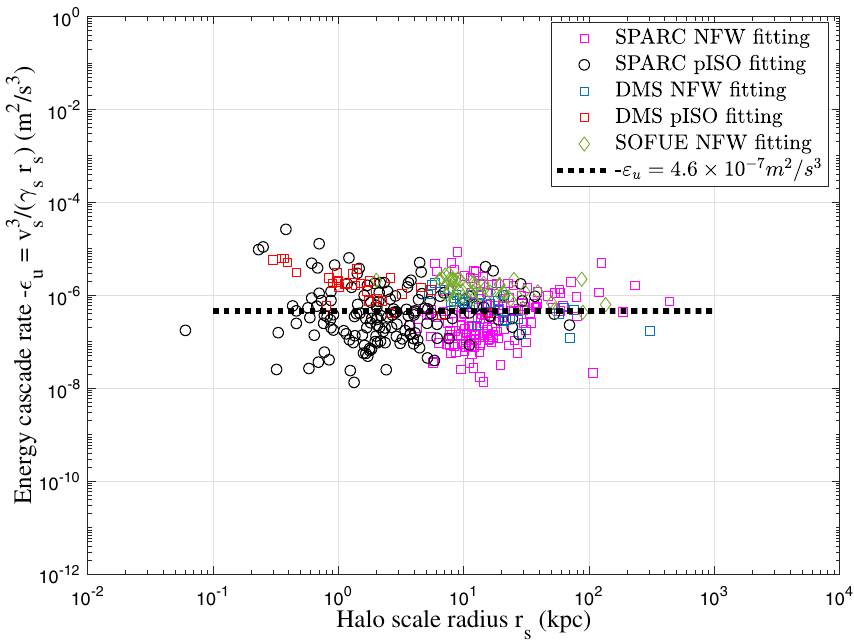
Figure 7. The constant rate of inverse energy cascade ε u from galaxy rotation curve data. The dispersion in data might come from the spatial intermittence of energy cascade. Dwarf galaxy tends to have smaller ε u